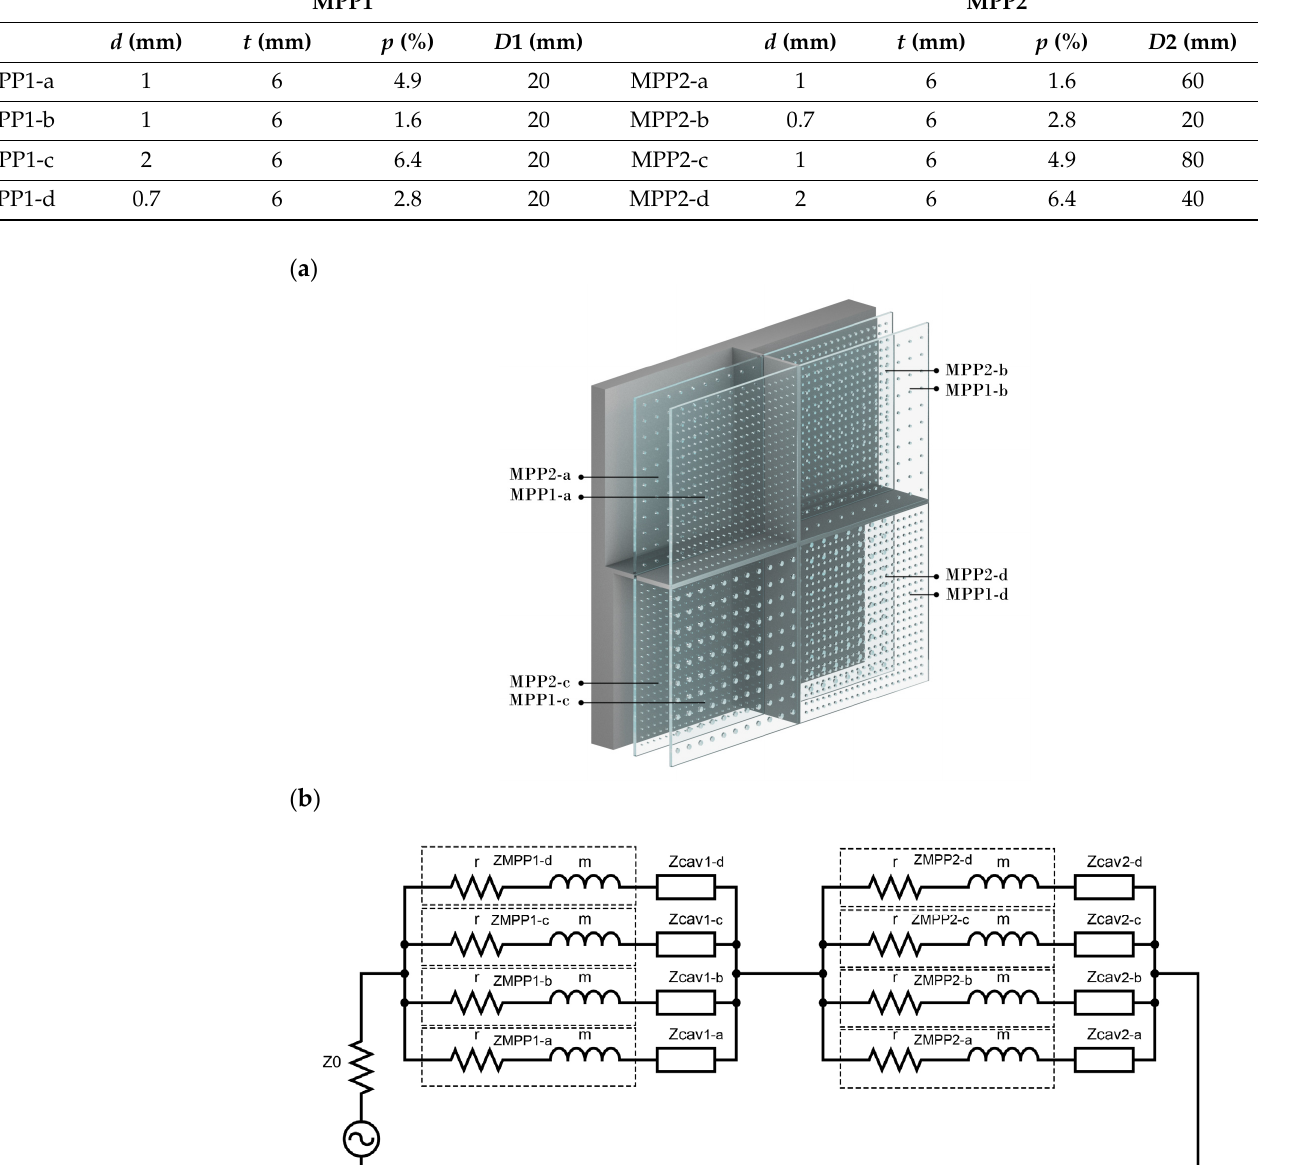
Figure 3. ( a ) Two layers of parallel-arranged MPPs with different back cavities. ( b ) The respective equivalent circuits of two layers of parallel-arranged MPPs with different back cavities after each layer.